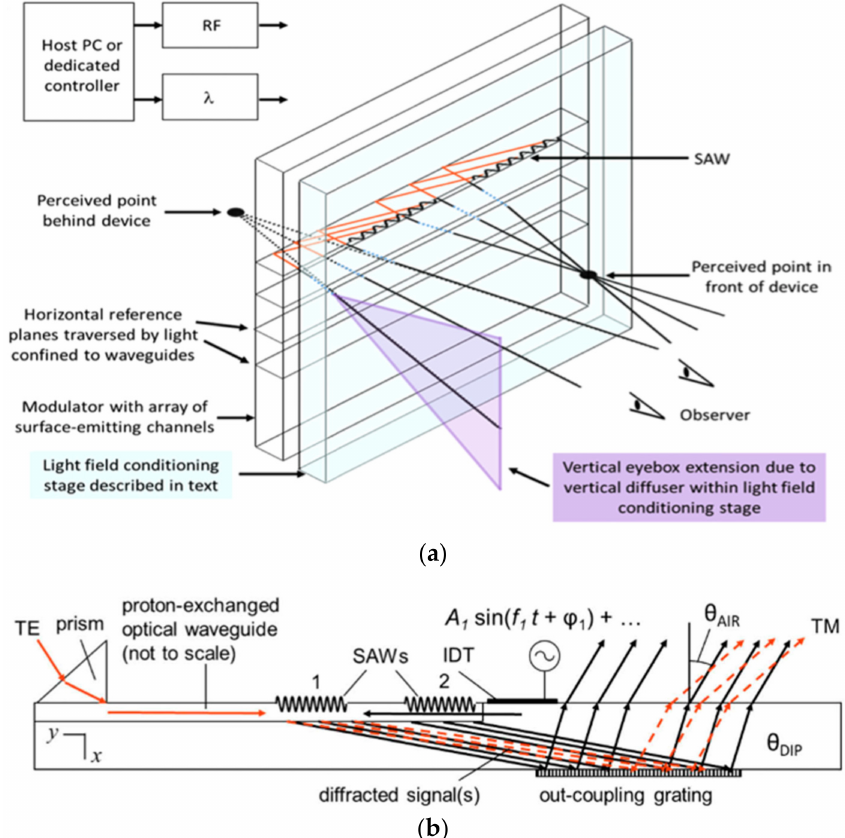
Figure 21. ( a ) An envisioned architecture for an electroholographic display using top-surface-emitting leaky mode modulator projects imagery into a display volume that straddles the device. ( b ) Cross- sectional view of a top-surface emitting leaky mode modulator. SAWs modulate waveguide light into a diffracted signal that propagates to a back surface grating and upwards through the device into air. Its addressable angular subtense can be increased by methods cited in the text. Reprinted with permission from Optics Express